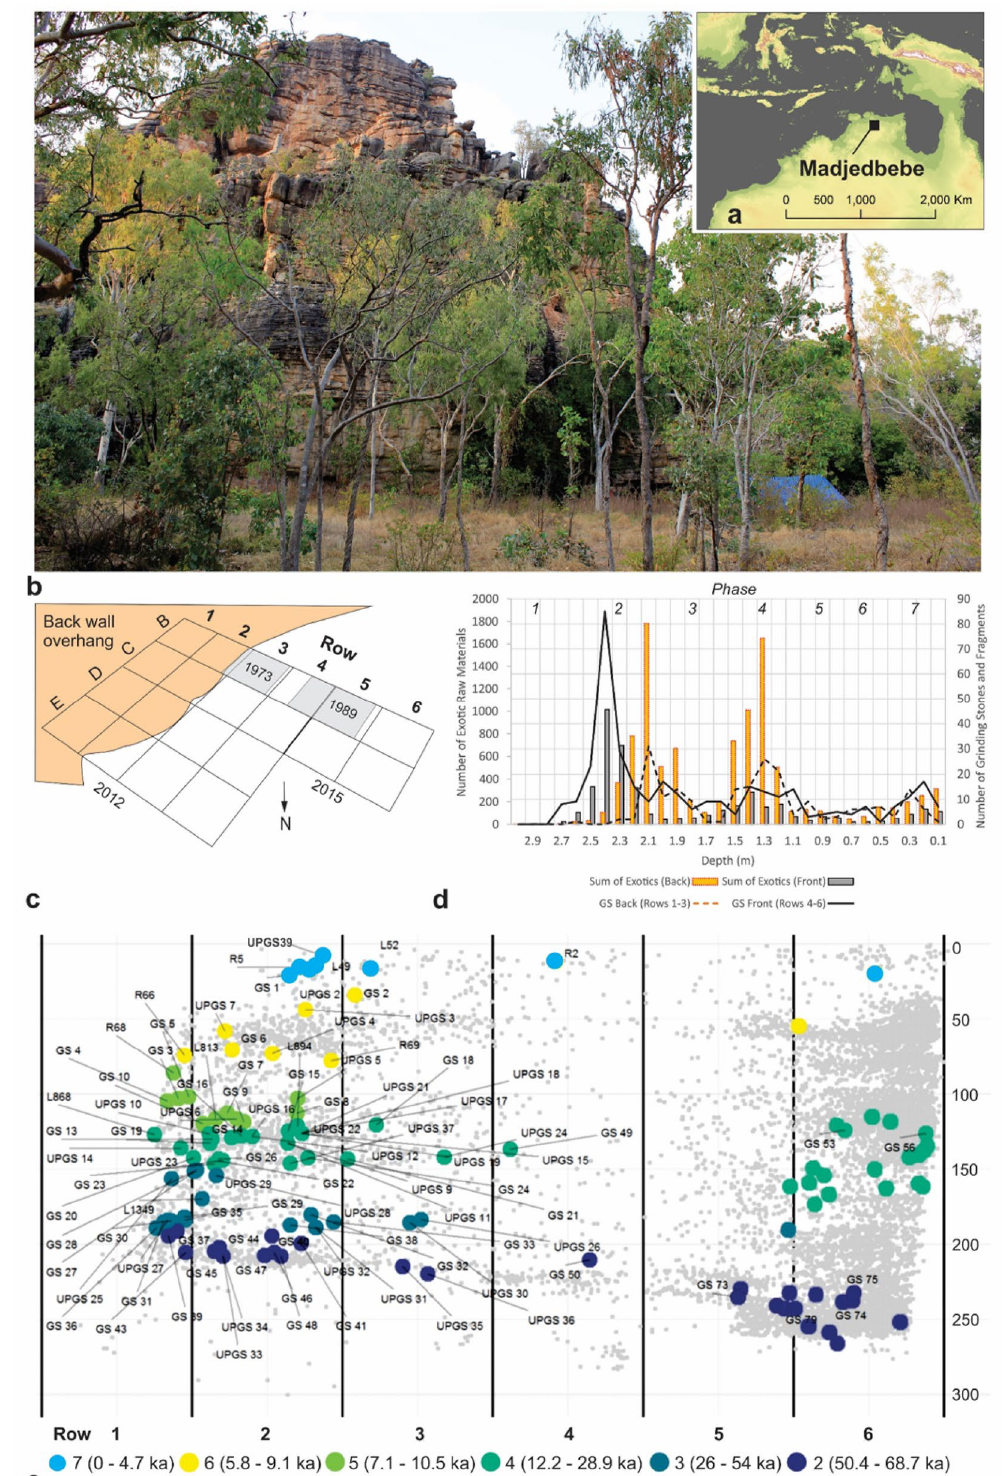
Figure 1. Location of Madjedbebe, site layout and the distribution of grinding stones. ( a ) Location of the site. Sea levels are shown at −80 m bsl equivalent to MIS 3; (b) Photo of the Madjedbebe and Djuwamba massif taken from the north. The blue tarp indicates the location of the excavation against the rockshelter wall (photo courtesy of Tiina Manne); ( c ) Grid layout of site showing 1973 (B3), 1989 (B4-5), 2012 (B1-E4) and 2015 (B5-C6) excavated areas and location of the back wall; ( d ) Frequency distribution of grinding stones and exotic raw materials by depth. The assemblage is divided into front (rows 5–6) and back (rows 1–3) to account for the 5° slope in stratigraphy from the back to the front; ( e ) Location of 3-D plotted grinding stones at Madjedbebe colour-coded by Phase. Grey dots represent lithics, ground ochre and other artefacts. Row 1 is closest to the back wall of the rockshelter and Rows 5 and 6 are located outside the dripline. Rows 4 and 5 show fewer plotted artefacts as B4 and part of B5 they were excavated in 1989 and artefacts were not plotted in